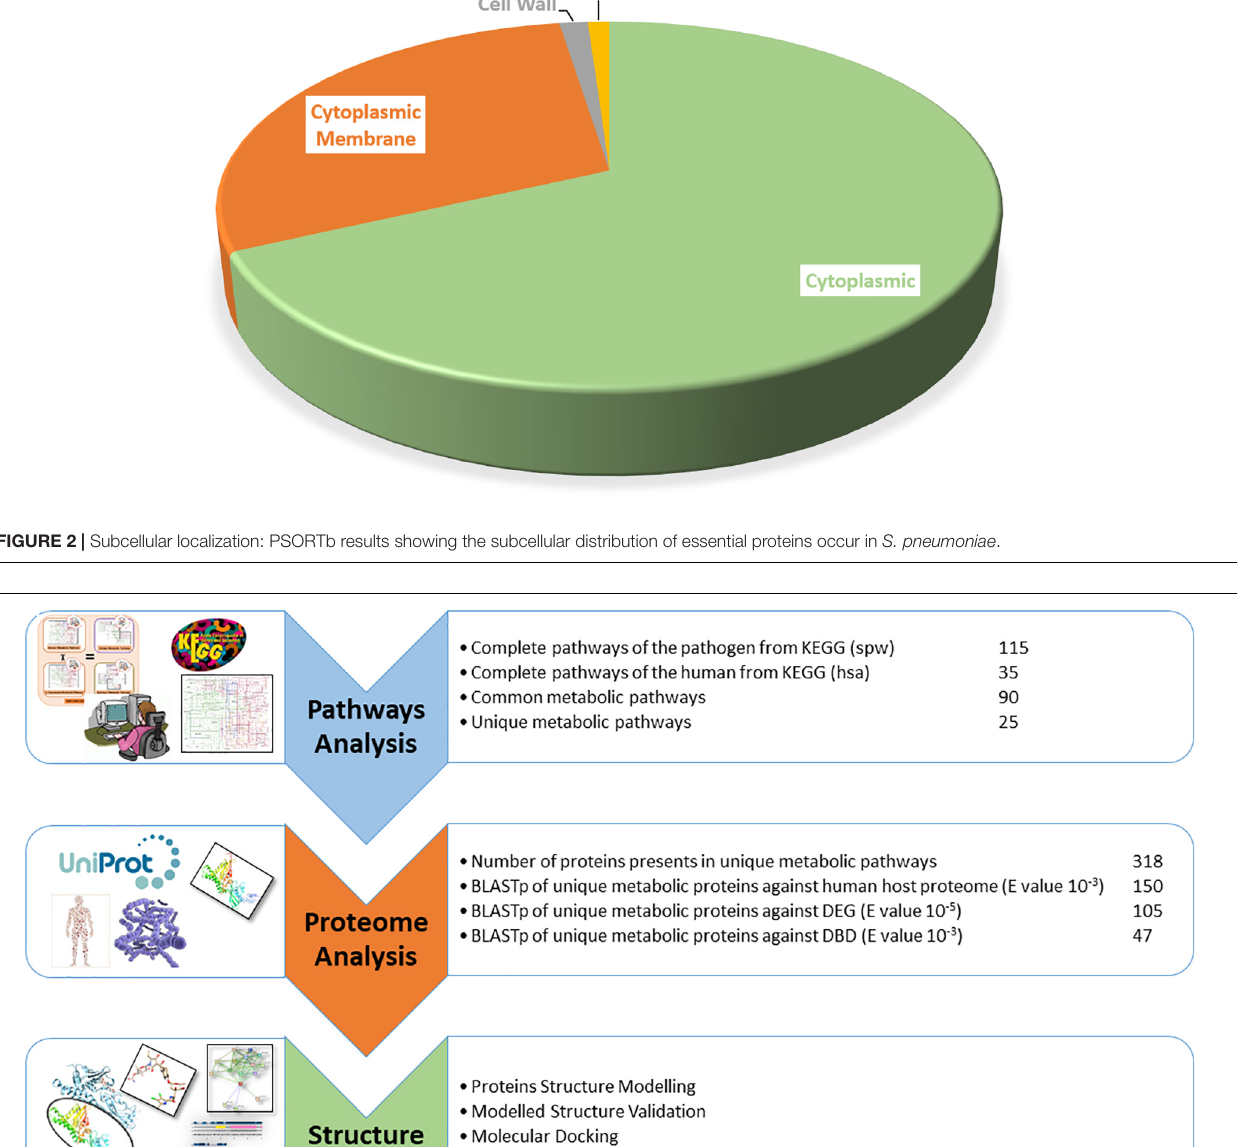
(SP14-BS69), and A5M9S2 (strain SP14-BS69), respectively. These proteins showed conservancy of 100–93% when analyzed through MSA ( Supplementary Figure 2